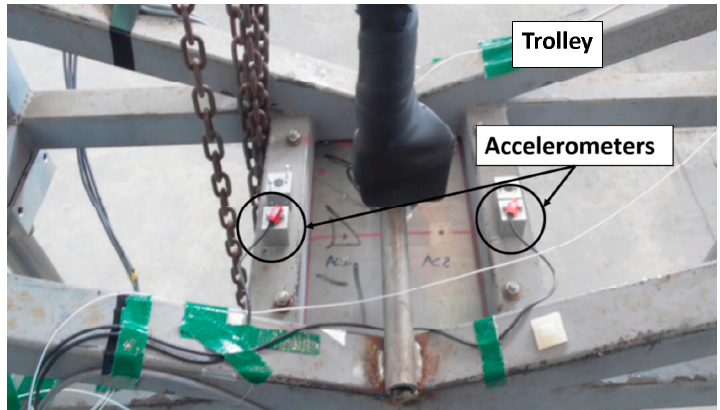
Figure 4. Test article/interface plate/trolley system, as it touches the two impact plates mounted on the ground.